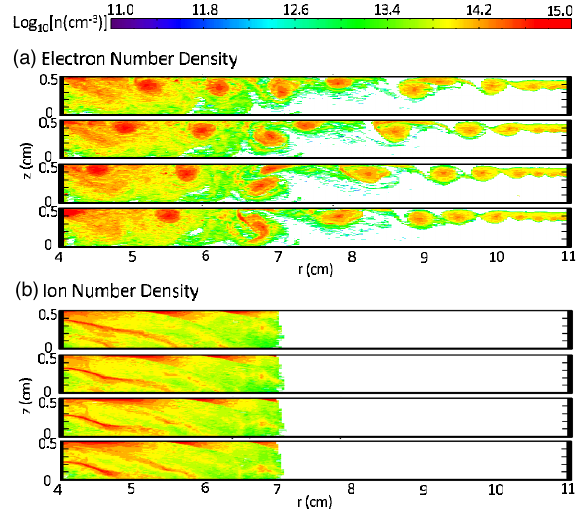
FIG. 3. (a) Electron and (b) ion (O þ 1 ) number densities plotted at t ¼ 30 . 1 , 30.2, 30.3, and 30.4 ns intervals. The electron sheath is injected from the r ¼ 11 cm boundary and O þ 1 ion emission is enabled along the anode between r ¼ 4 and 7